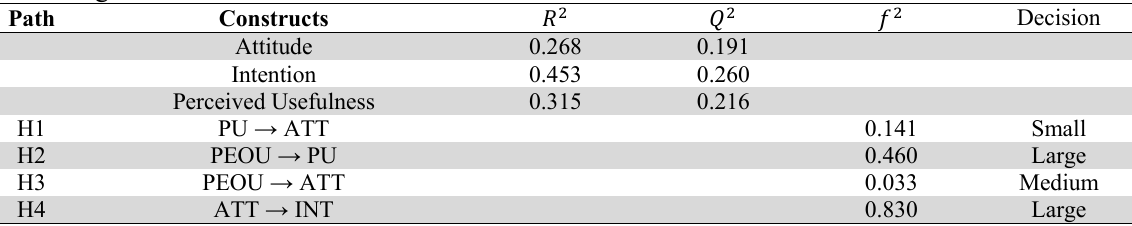
Evaluating Effect